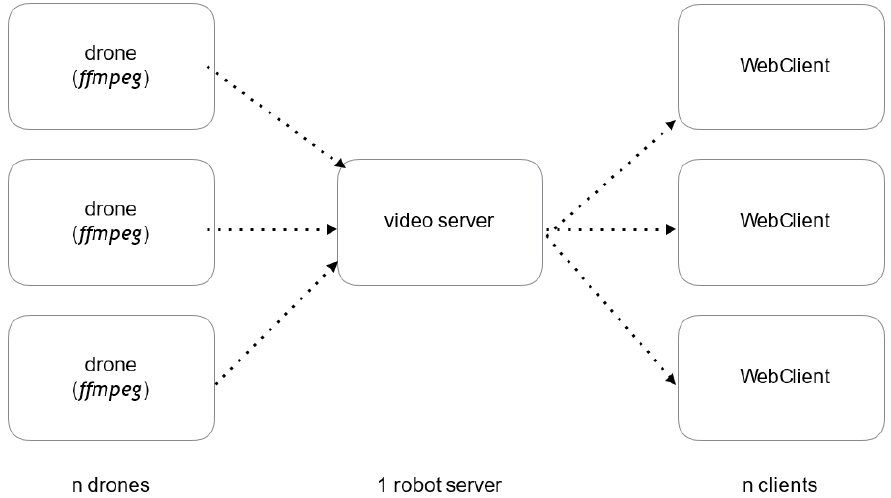
Figure 15. Multimedia transmission